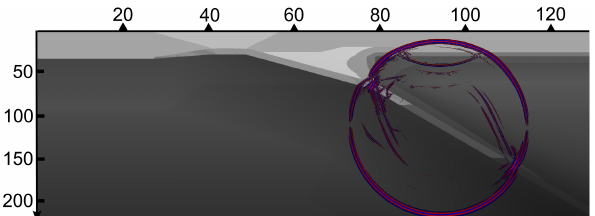
Fig. 6: Snapshot of vertical displacement illustrating general setup of the numerical model. Propagation time is 13.2 s. An explosive source radiates P waves travelling up the slab. In- side the oceanic crust, the P wave is already slightly delayed but the wavefront is still attached to the waves propagating in the surrounding mantle. At the upper and lower interface, PS conversions have developed. They can be identified by their smaller wavelength. Vertical axis annotation gives depth in km. Horizontal axis specifies index of receivers. Color shad- ing for displacement displays negative values as blue and positive values as red shades. Color scale is nonlinear. RGB values are proportional to normalized absolute value of dis- placement to the power of 0.3 enhancing low-amplitude dis- placements. Displacements less than 1 percent of the maxi- mum value are